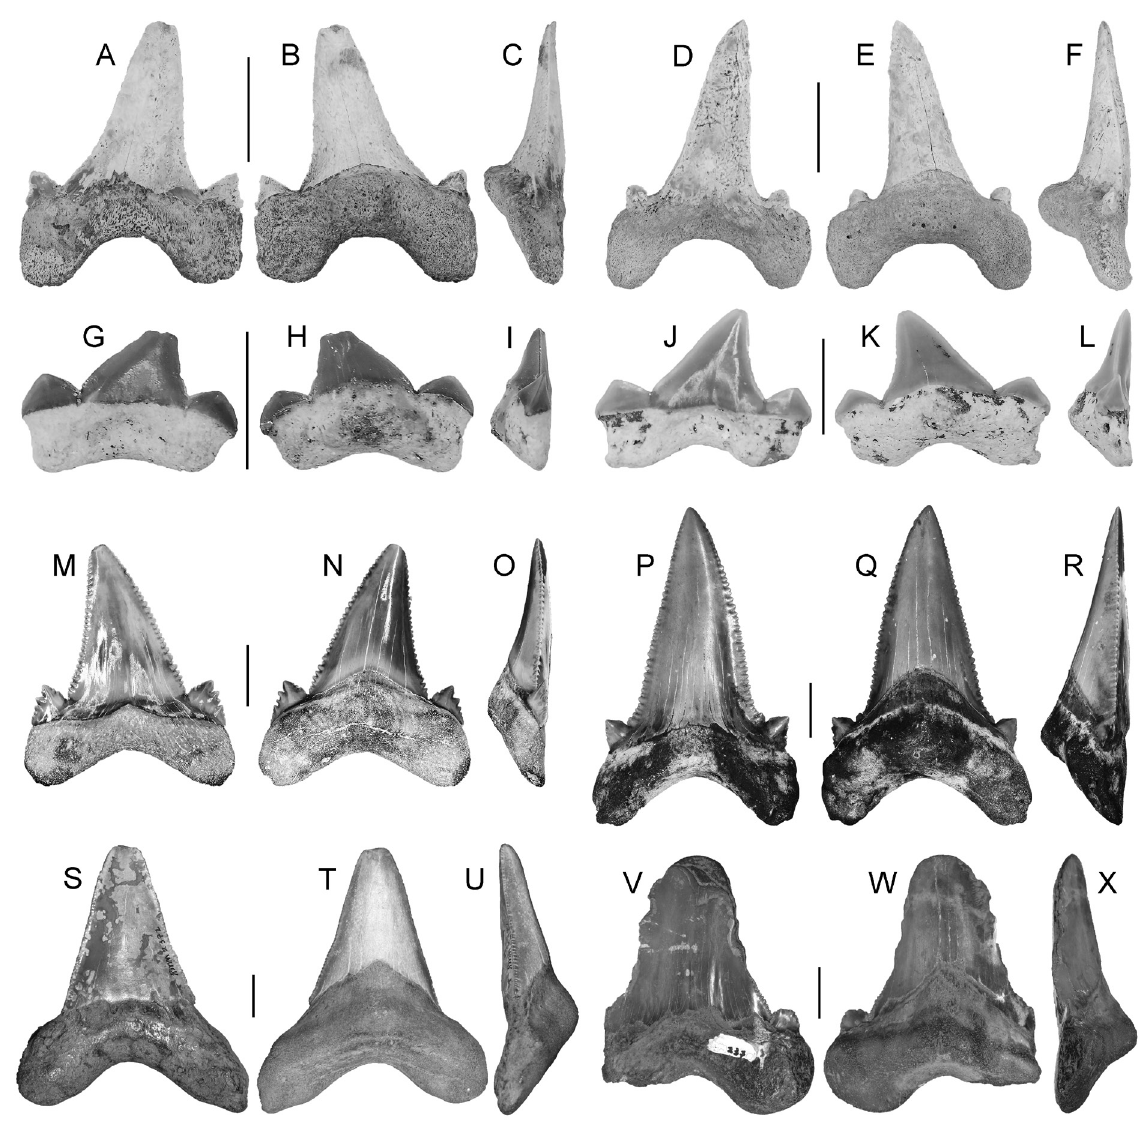
Fig. 9. Otodontidae Glikman, 1964, teeth. A – L . Otodus ( Otodus ) sp. A–C . MSC 2999.2, lower Tallahatta